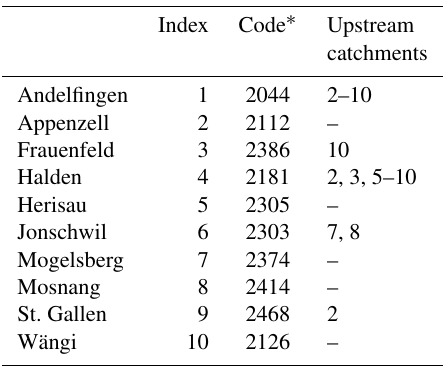
Table 1. Identification of the gauging stations and description of the river network. Index Code ∗